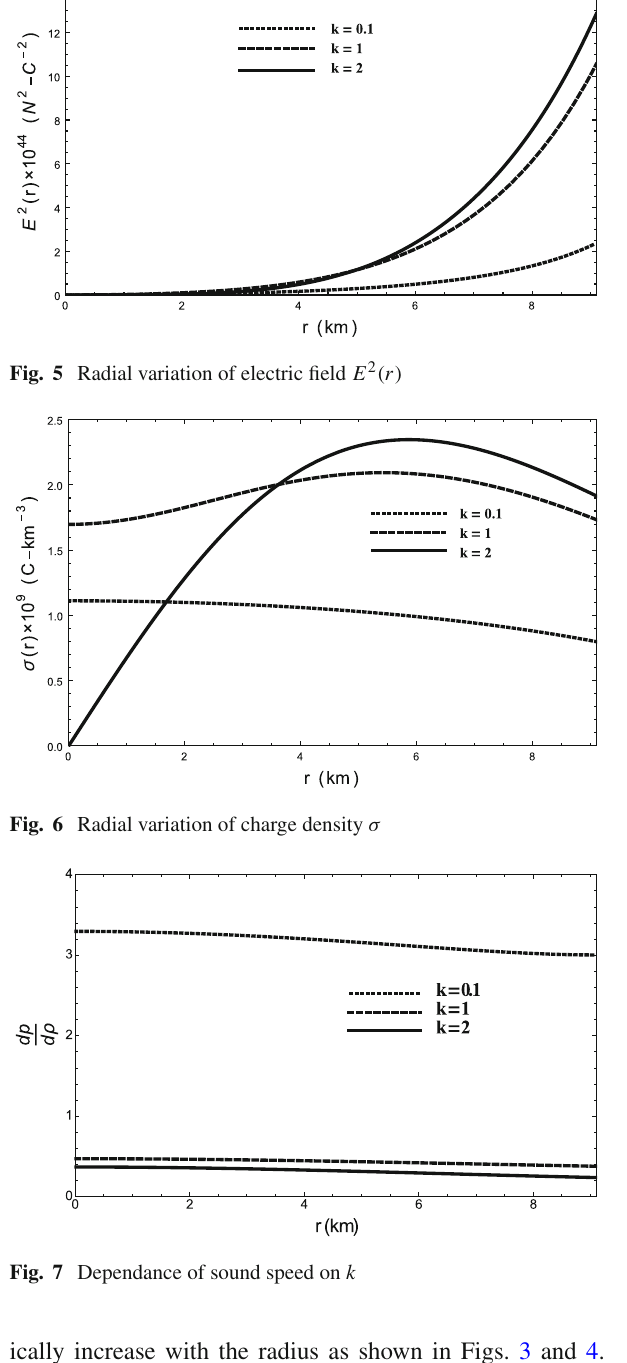
ically increase with the radius as shown in Figs. 3 and